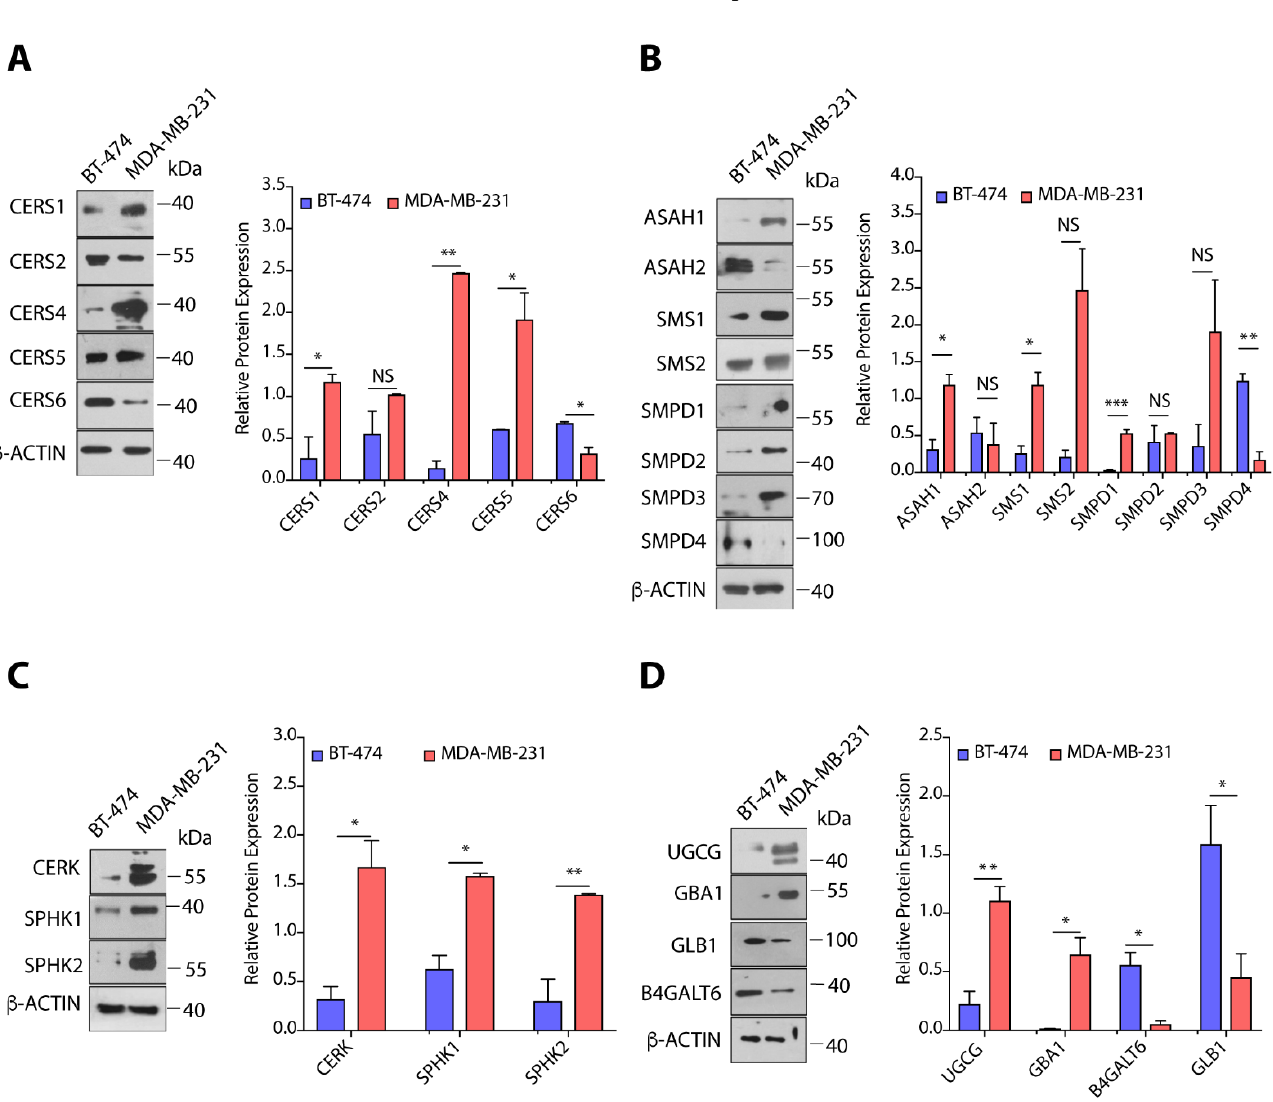
Figure 4. ( A – D ) Immunoblots and quantification of different proteins of sphingolipid metabolic pathway in BT-474 and MDA-MB-231 cells along with representative β actin as control. Protein expression was normalized with representative β -actin as control. Details of all Immunoblots with originals are provided in Figure S4. Data are presented as mean ± SEM of at least three independent replicates, and were analyzed by unpaired student’s t -test. p -value: * p < 0.05, ** p < 0.01, *** p <